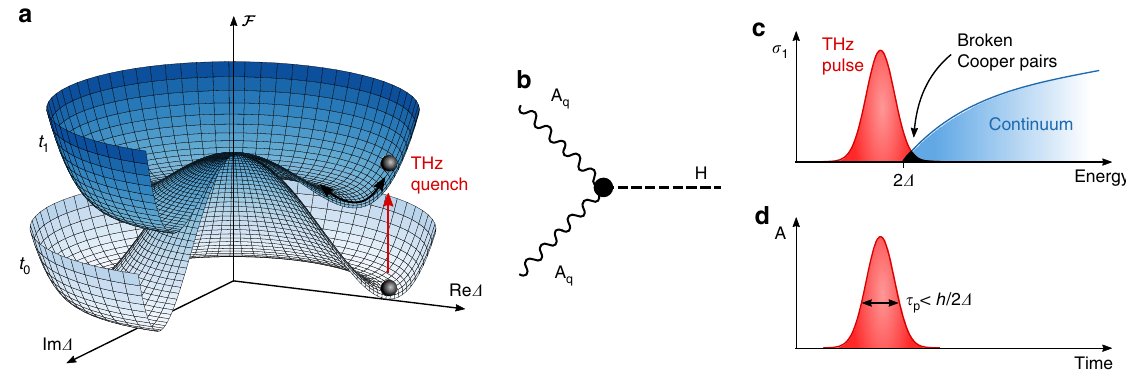
Fig. 1 Illustration of Higgs oscillations in a superconductor . a Free energy landscape F of a superconductor as a function of the real and imaginary part of the superconducting gap Δ . After a quench at t 1 > t 0 , the free energy is suddenly changed, exciting the superconducting condensate and leading to collective Higgs oscillations, indicated by a black arrow. The red arrow indicates a quench by a THz light pulse. b Feynman diagram describing the excitation of a Higgs mode H by a light fi eld A using the Raman vertex. An infrared excitation of the Higgs mode (not considered here) is only possible if an external current is present. c Higgs excitation mechanism using a THz quench pulse. The quench pulse only slightly overlaps with the quasi-particle continuum indicated in blue. The Mexican hat shrinks due to the breaking of Cooper pairs. d To excite the Higgs oscillation, the pulse must ful fi ll the nonadiabaticity condition in time